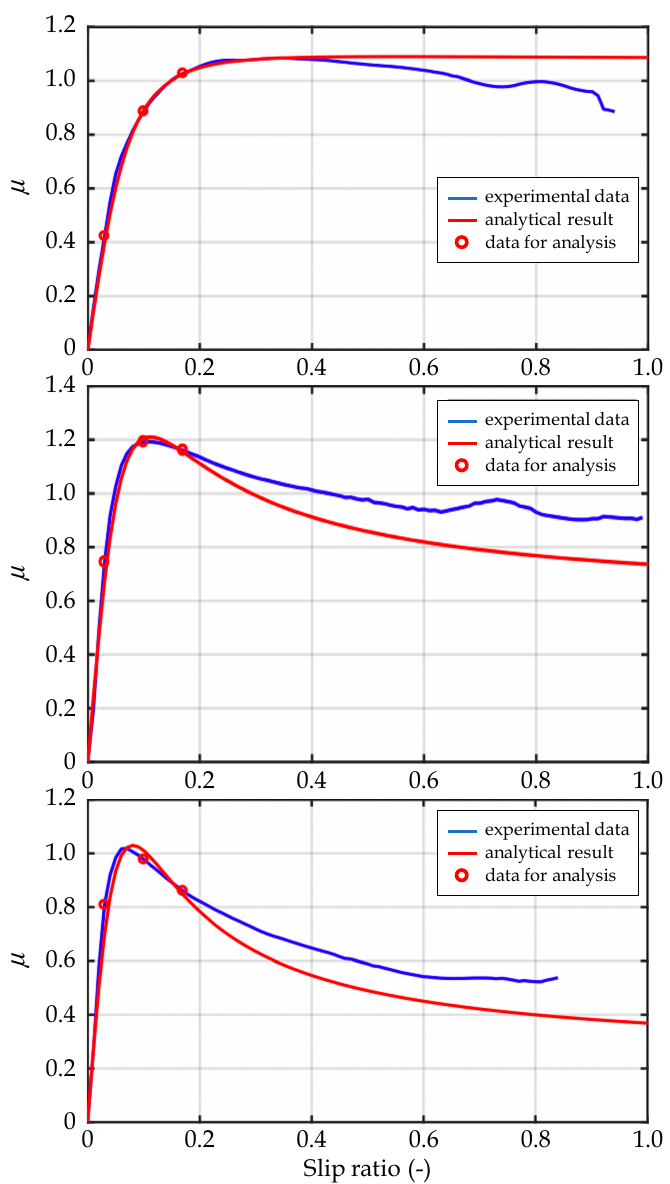
Figure 12. Identification results of μ - s characteristics by three different points ( s = 3, 10, 17%).